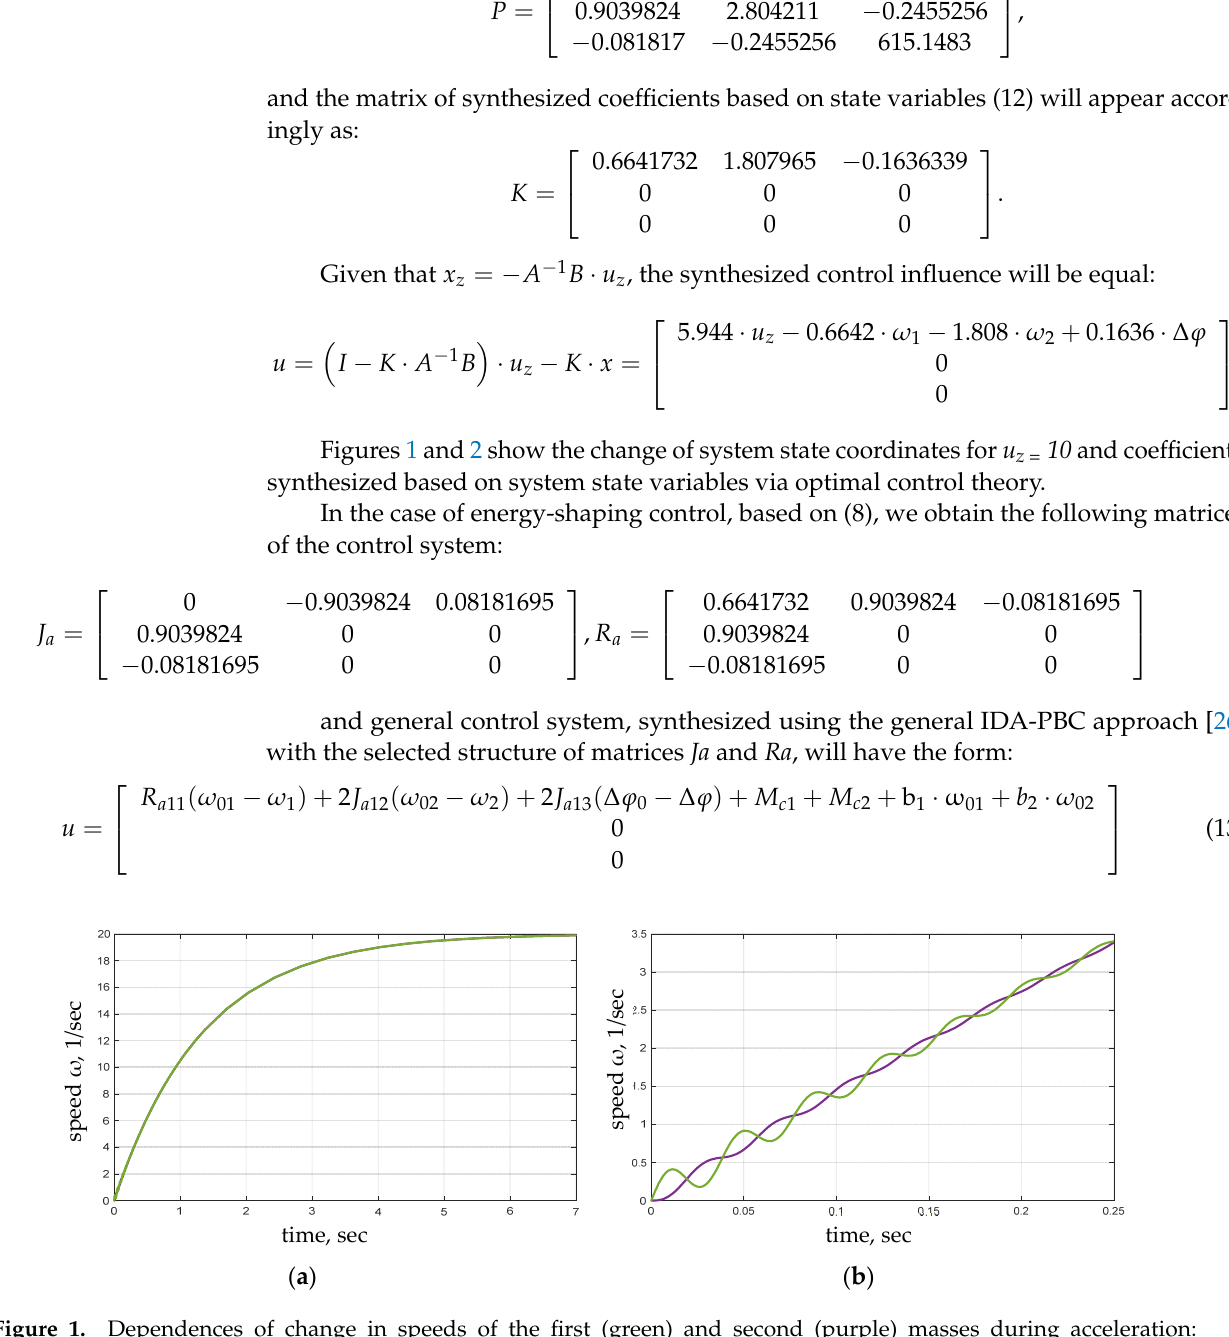
Figure 2. Dependence of the change in the twist angle ϕΔ during the acceleration process. Received energy-shaping control (13) provides the same behavior, as shown in Figures 1 and 2.